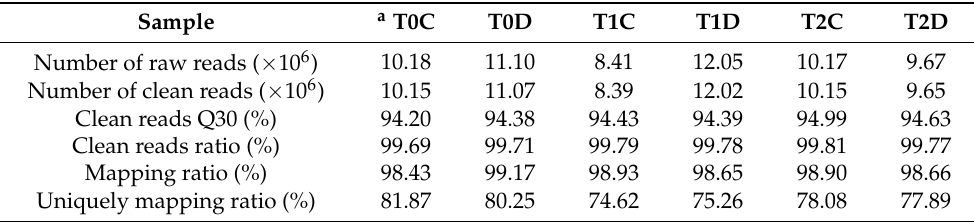
Table 1. Sequencing and assembly statistics of YN2 transcriptome data.